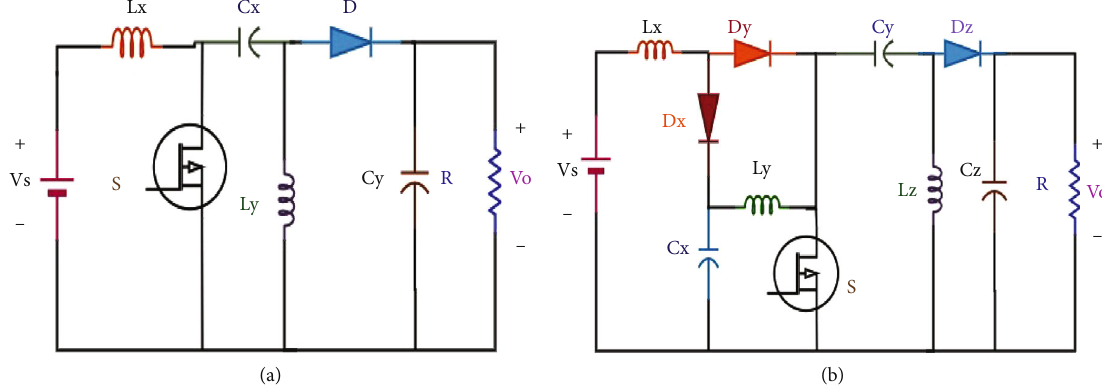
Figure 2: (a) Conventional SEPIC converter and (b) proposed MSC circuit diagram.